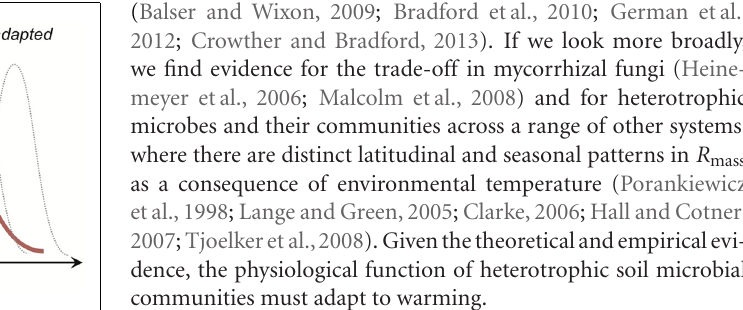
FIGURE 5 | Catalytic rate responses to temperature, caused by the evolutionary trade-off between enzyme structure and function, giving rise to different distributions of isoenzymes in cool- and warm-adapted organisms. An isoenzyme (gray dotted curves) is an enzyme with the same function but a different structure. In any one organism, population or community we expect a different set of isoenzymes to be expressed at different temperatures.This is because enzyme structure usually only promotes efficient substrate-binding and product-release across a narrow temperature window. As such, the aggregate activity of a cool- or warm-adapted organism, population or community (depicted as thick blue dotted and red solid lines for cool- and warm-adapted) results from the activities of a family of isoenzymes expressed across the environmental temperature